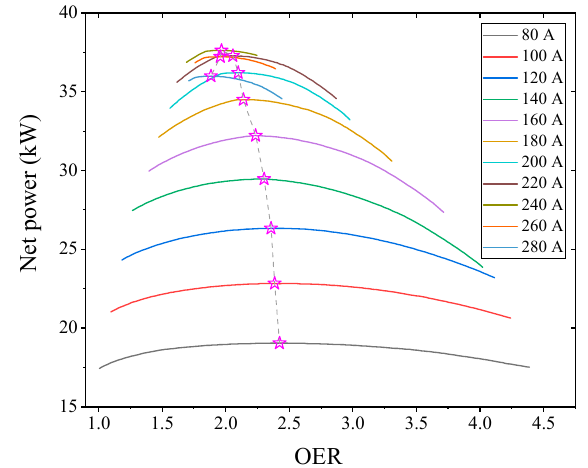
Figure 2. Optimal reference for OER at different load currents.